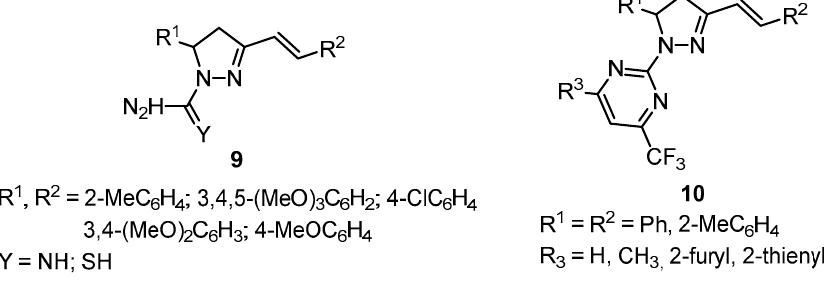
Figure 4. 5-Aryl-3-styryl-1-carboxamidino-1 H -pyrazole derivatives presenting antioxidant and antimicrobial activity 9 and 10 [35].